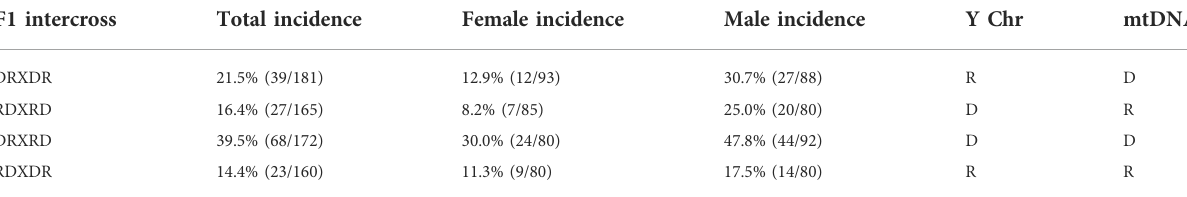
TABLE 1 Incidence of alloxan-induced diabetes in each direction of the F2 cohort. F1 intercross Total